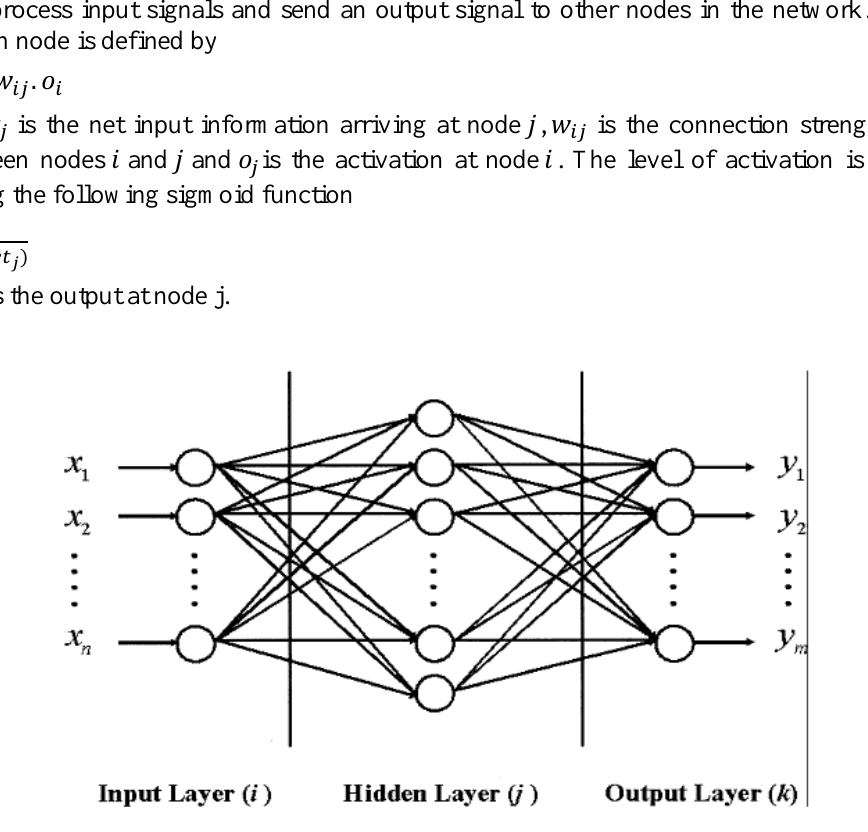
Fig. 1 A General Architecture of an Artificial Neural